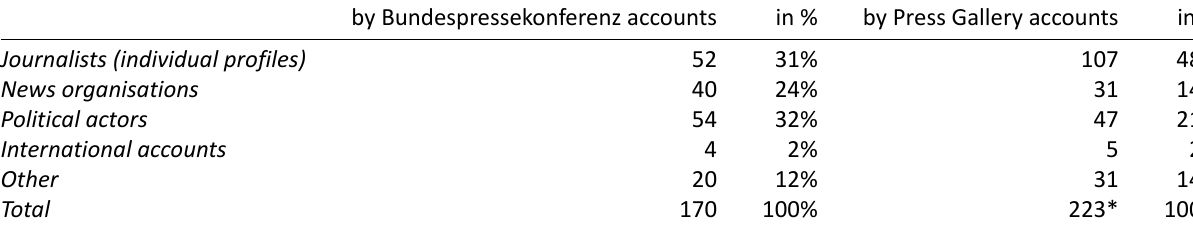
Table 5. Most @mentioned types of accounts